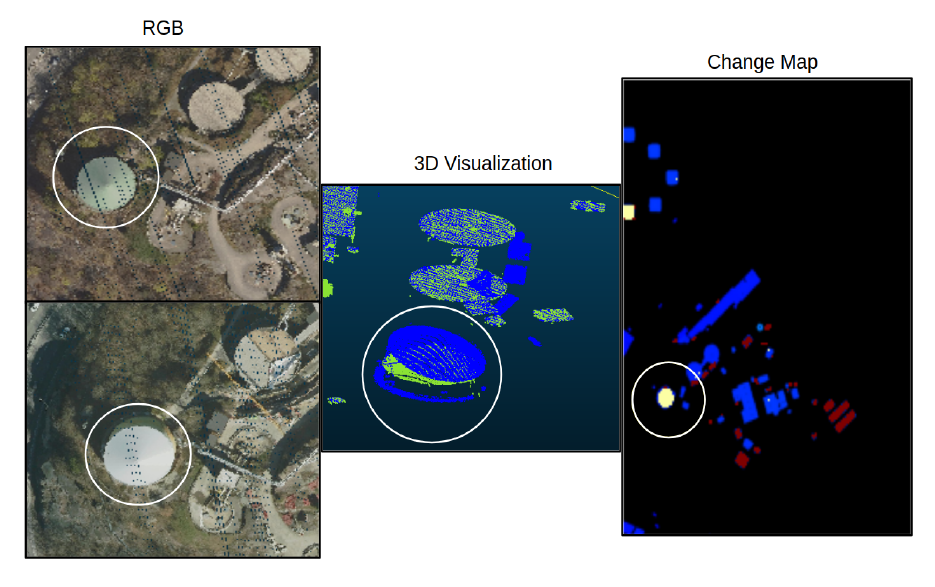
Figure 7. Negative Change Detection sample.